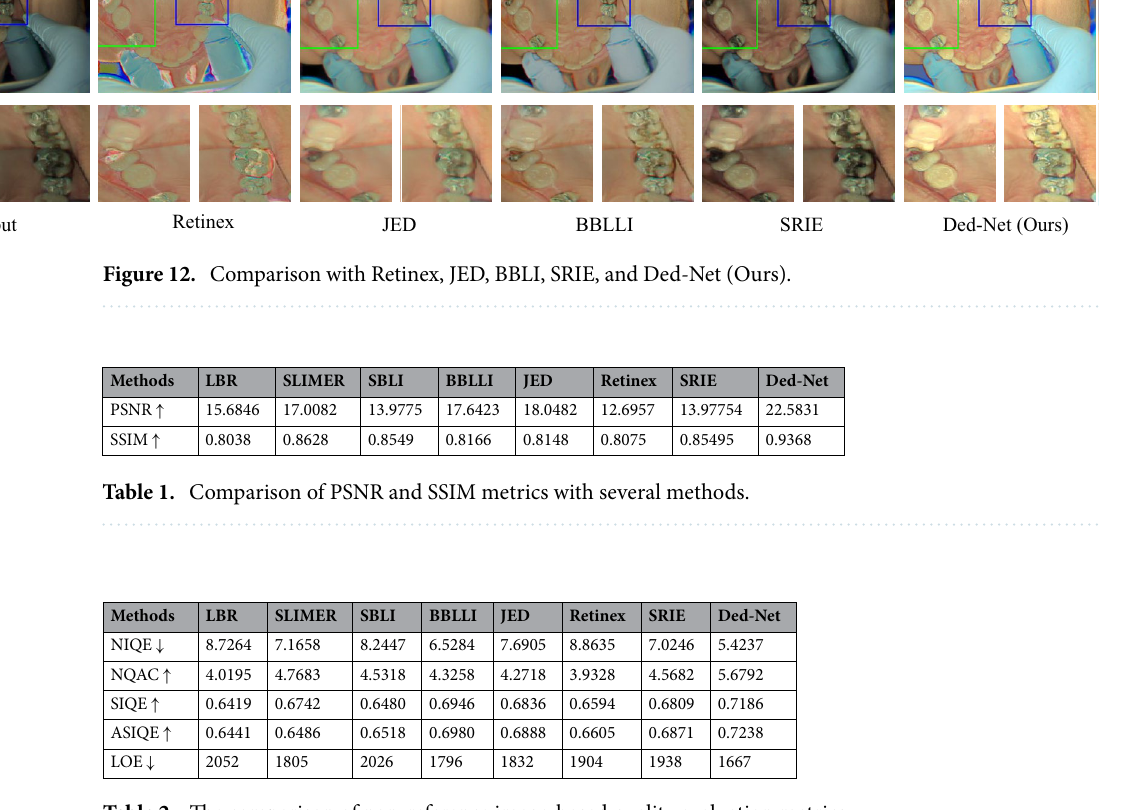
Table 2. The comparison of non-reference image-based quality evaluation metrics.